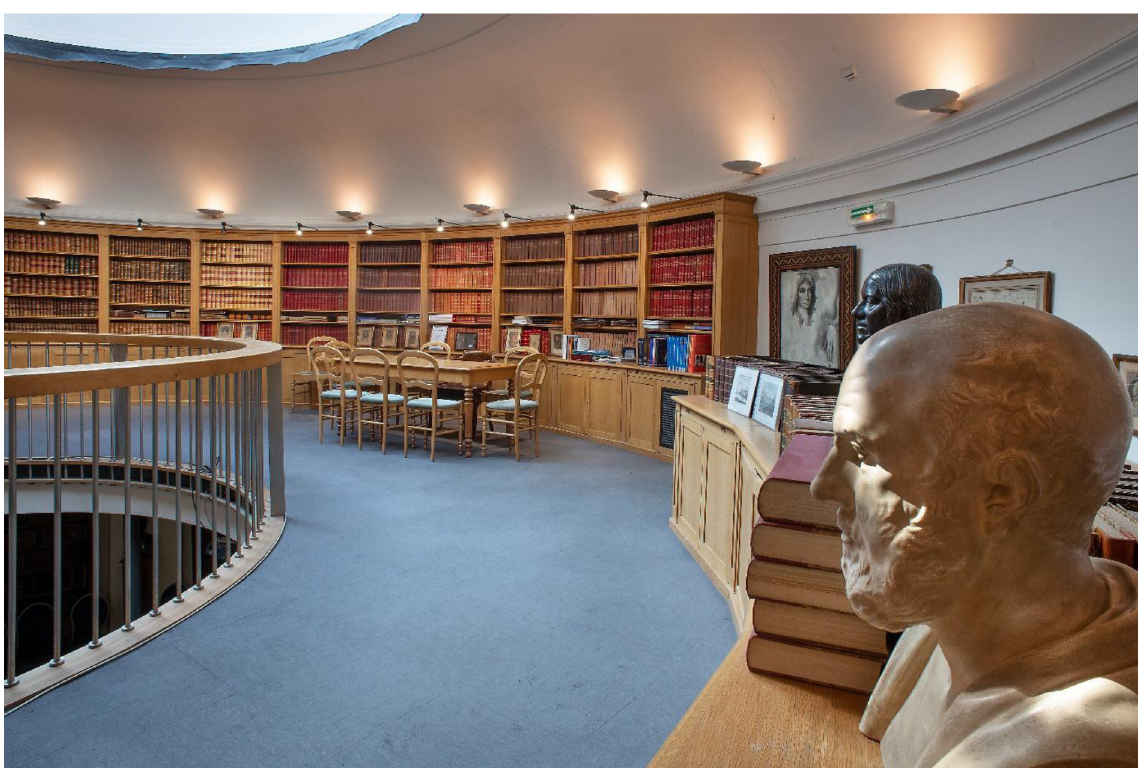
Fig. 5. Library, current seat of the